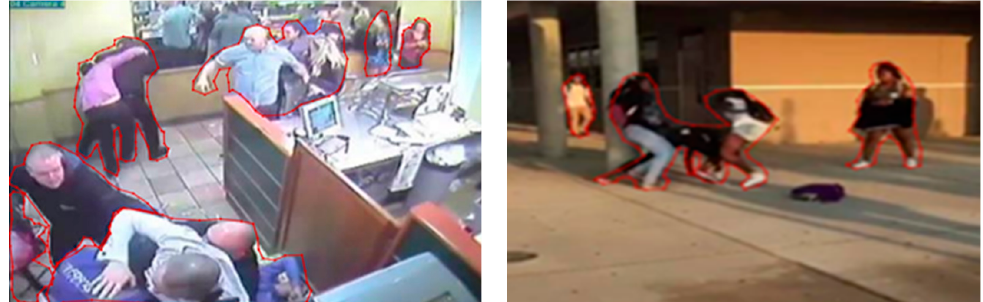
Figure 2. Annotation of violent video frames. The red curve is the annotation.